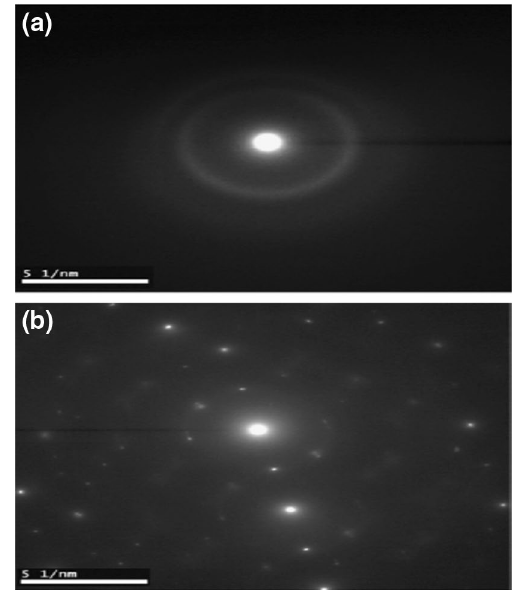
Fig. 17 Topographic image [93]